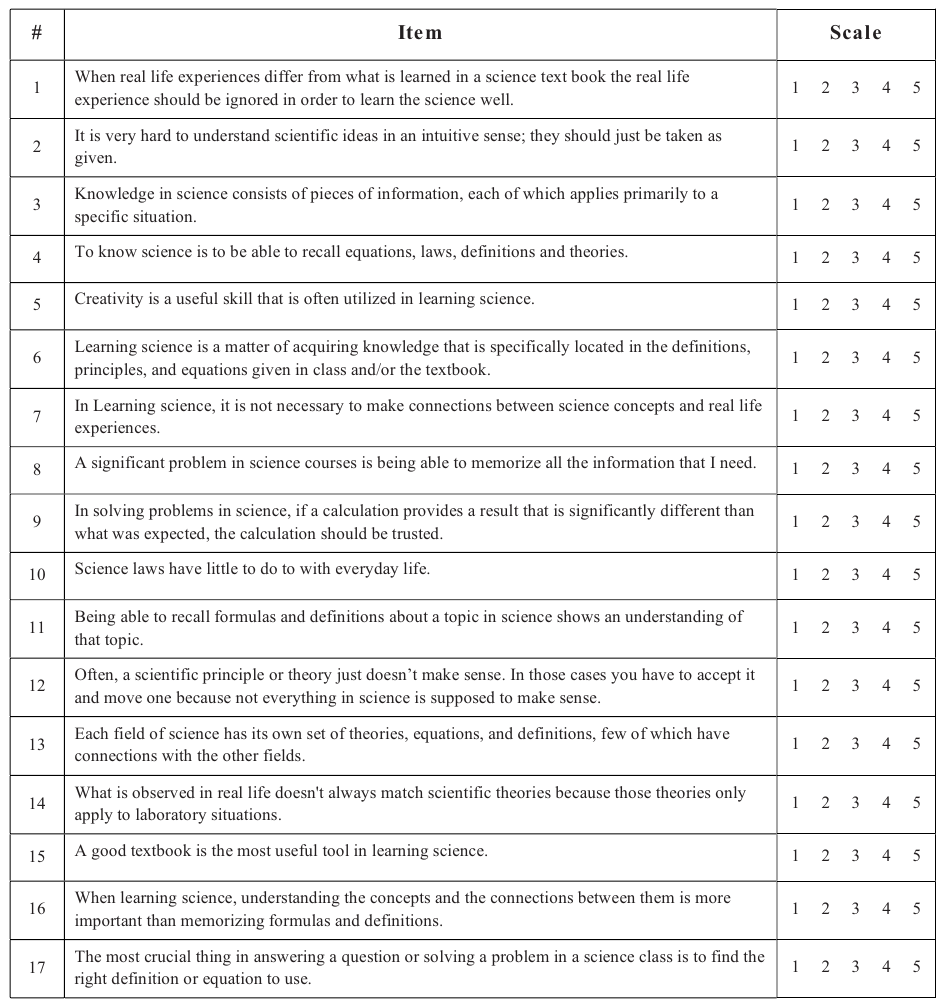
FIG. 3. Epistemological survey administered at the beginning and end of the summer program. For each item, students were asked to circle a number between 1 (cid:1) strongly disagree (cid:2) and 5 (cid:1) strongly agree (cid:2)